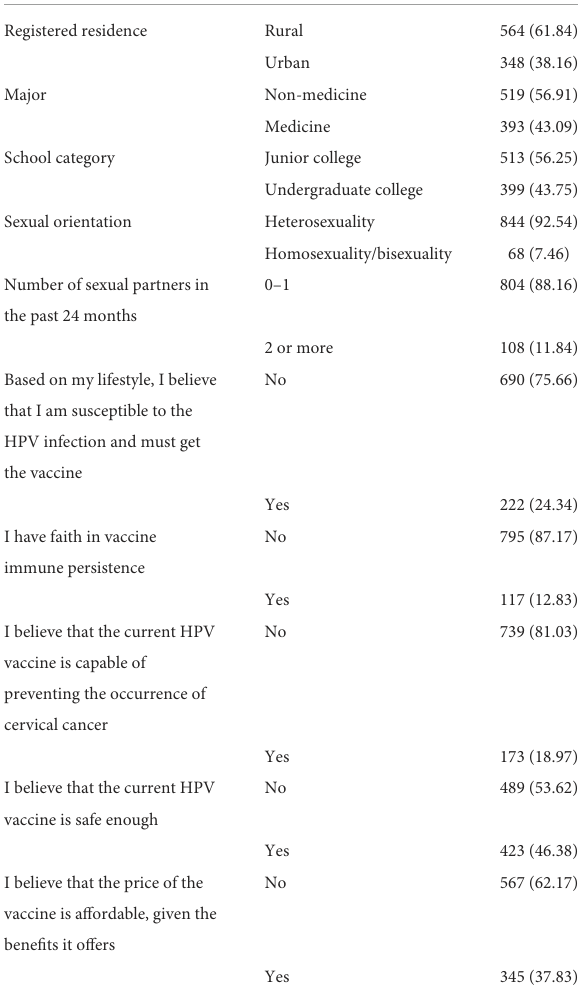
TABLE 1 Demographic characteristics of all